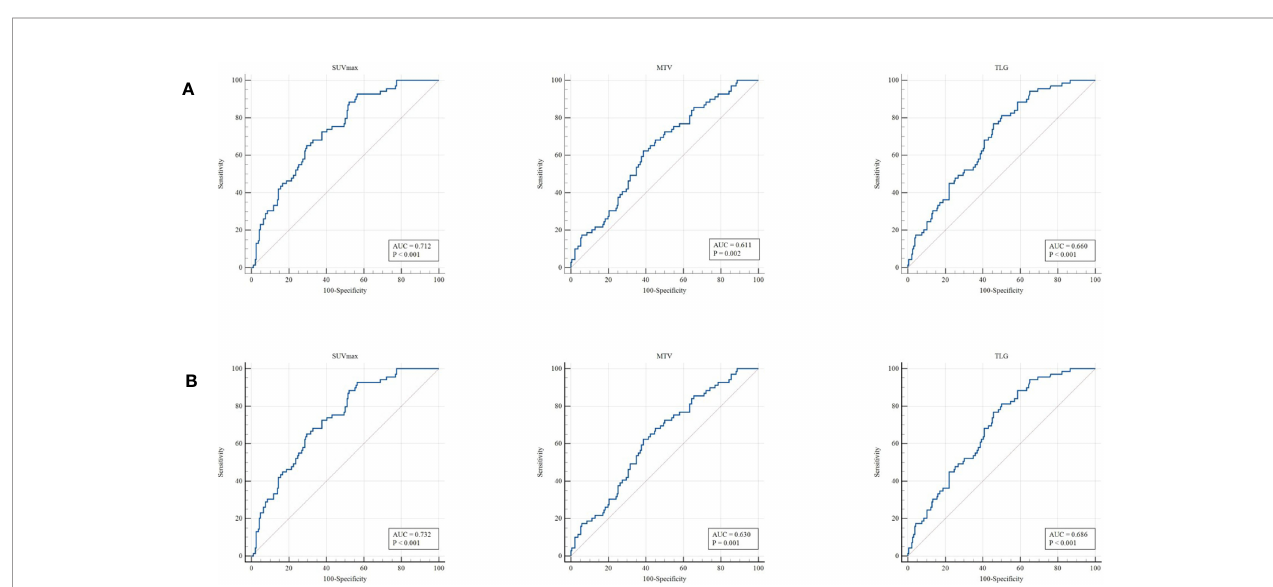
FIGURE 3 | ROC curve for the determination of the most discriminative cutoff points for SUV max , MTV, and TLG in primary tumors. The optimal cutoff values of SUVmax, MTV, and TLG for the PD-L1 1% group (A) were 5.21, 123.94, and 216.62, respectively. The optimal cutoff values of SUV max , MTV, and TLG for the PD- L1 50% group (B) were 6.82, 137.57, and 191.68, respectively.